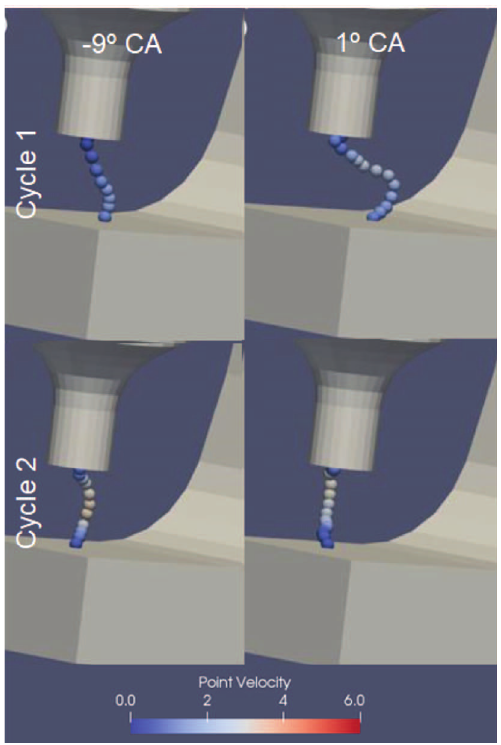
Fig. 10. WSR and LESI ignition model: arc movement as predicted by LESI for two representative cycles at different stages of ignition. Individual Lagrangian points are colored by the fl ow velocity at the particle